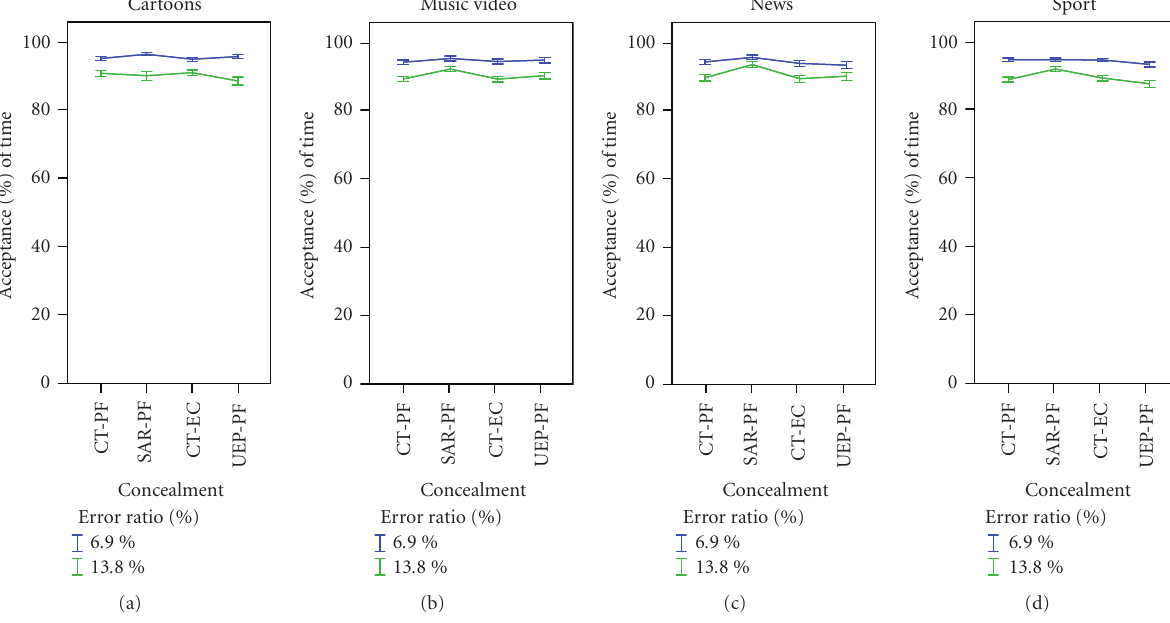
Figure 10: Acceptance percentage of time of di ff erent error rates and concealment methods for all contents. Error bars show 95% CI of